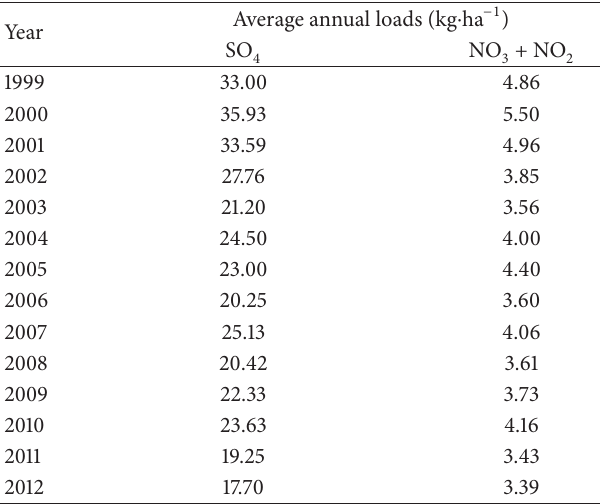
Table 1: Average annual loads (kg ⋅ ha − 1 ) contributed by the precipi- and (NO + NO ) in tation of SO 4 3 2